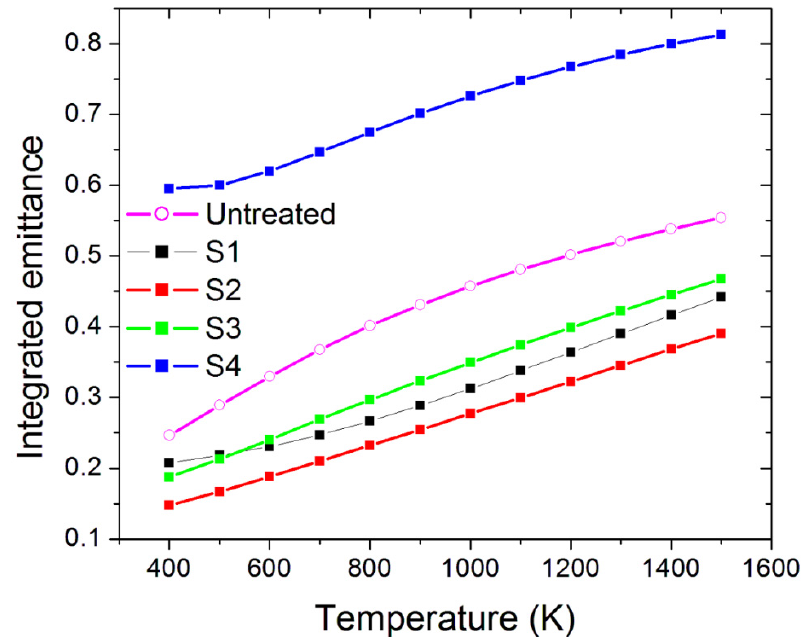
Figure 9. Integrated emittance of the four treated samples and the reference untreated one.